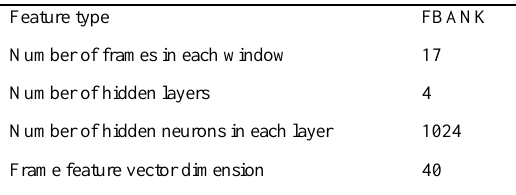
Table 1. Configuration of deep neural